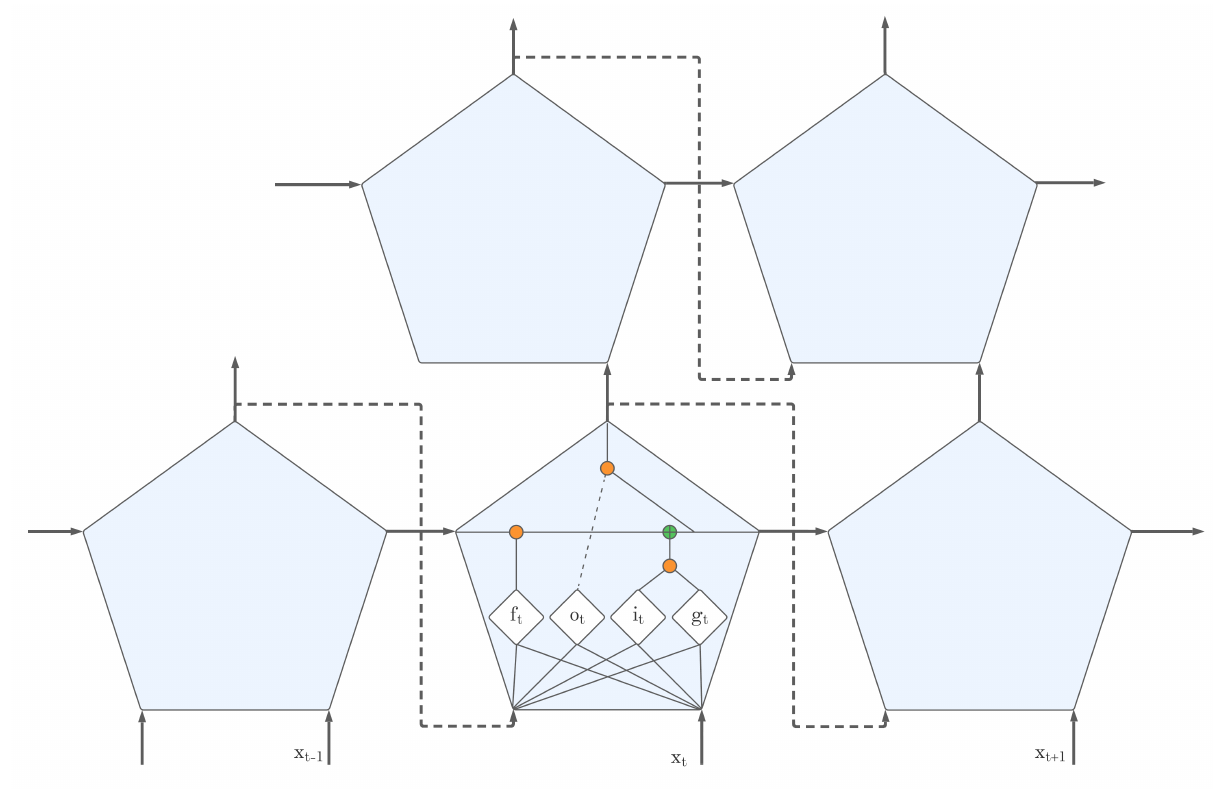
Figure 5. LSTM architecture when there is more than one